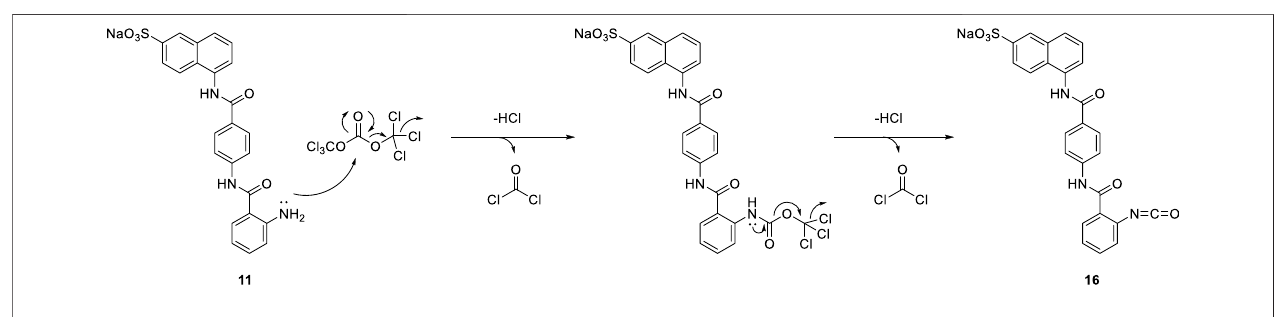
SCHEME 5 | A potential mechanism for the formation of compound 16